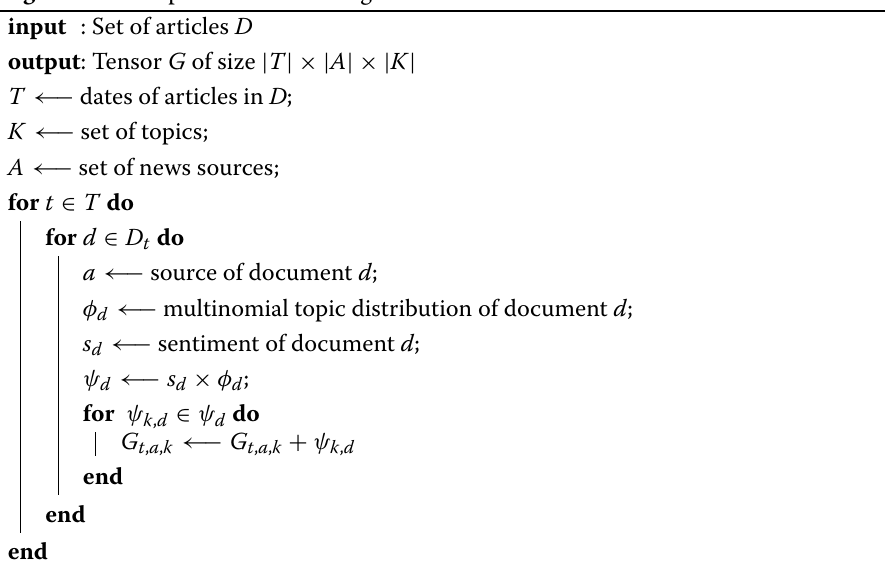
Algorithm 1: Topic-Sentiment